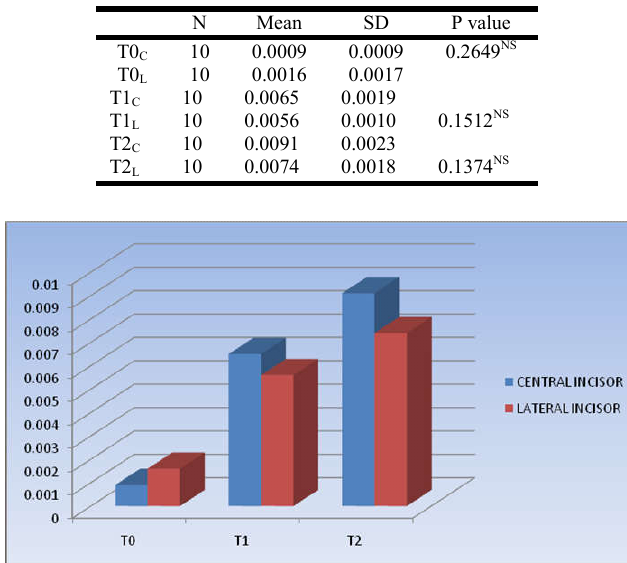
Graph 2. Comparision of DSPP levels ( ngL -1 ) between central and lateral incisors within control GROUP (T0), experimental group before intrusion (T1) and 2 months after intrusion